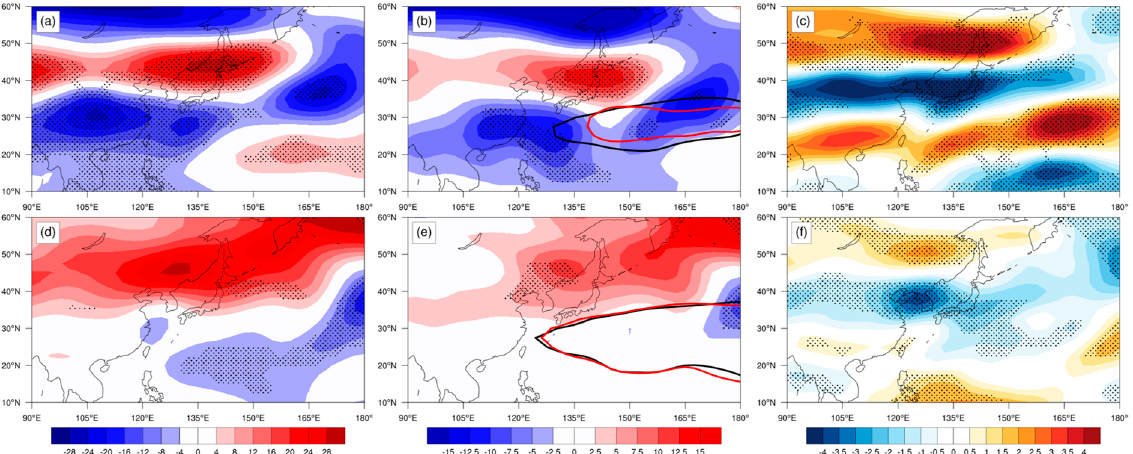
Figure 4. Composite differences of ( a , d ) 200 hPa geopotential height (unit: gpm), ( b , e ) 500 hPa geopotential height (unit: gpm), and ( c , f ) 200 hPa zonal wind (unit: m s − 1 ) between wet years and dry years. ( a – c ) for S1 and ( d – f ) for S2; dots indicate the regions exceeding 95% confidence level; red and black lines in ( b , e ) indicate composites of the WPSH feature line for wet and dry years, respectively).